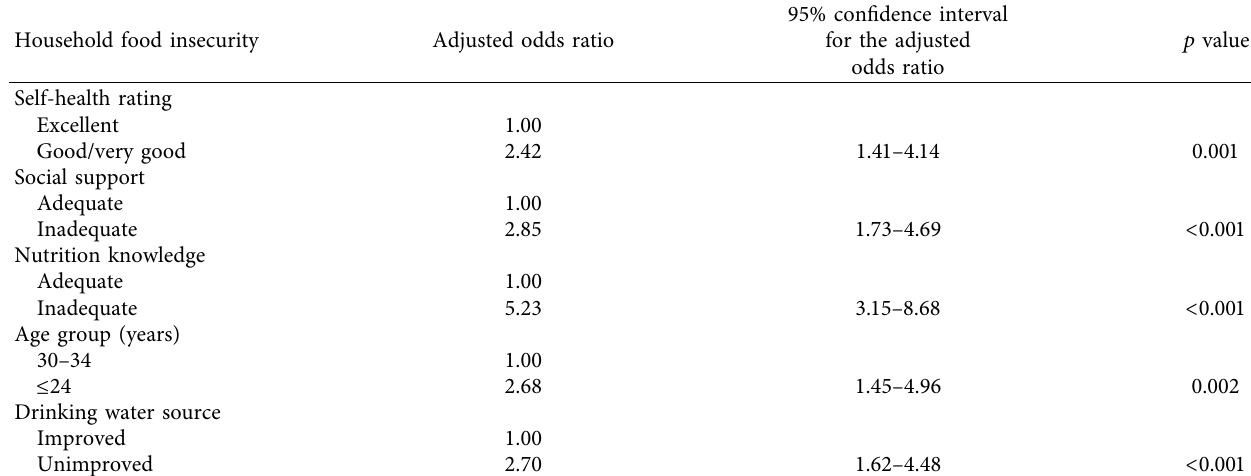
Table 2: Determinants of household food insecurity.